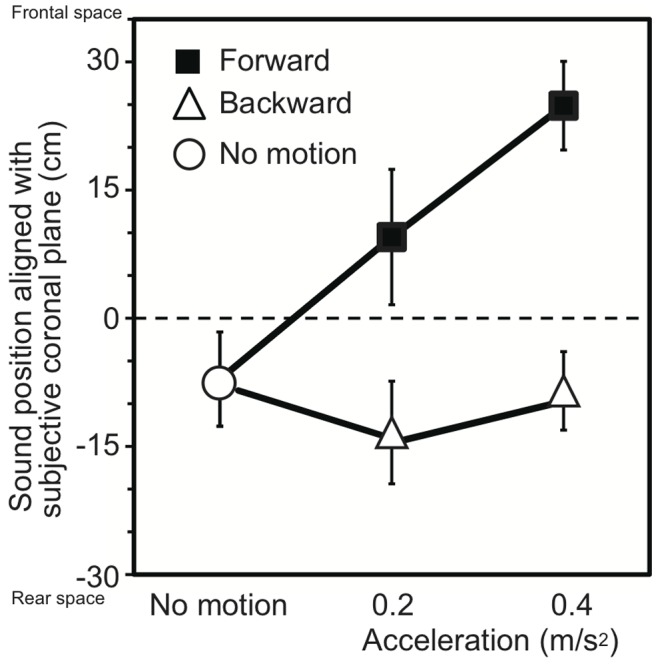
Effects of acceleration on auditory space representation observed in Experiment 1.The mean sound positions aligned with the participants’ subjective coronal planes are shown as a function of acceleration. The black squares and a white circle represent forward self-motion and no-motion, respectively, whereas the white triangles represent backward self-motion. The null point indicates the physical coronal plane. Error bars denote standard errors.